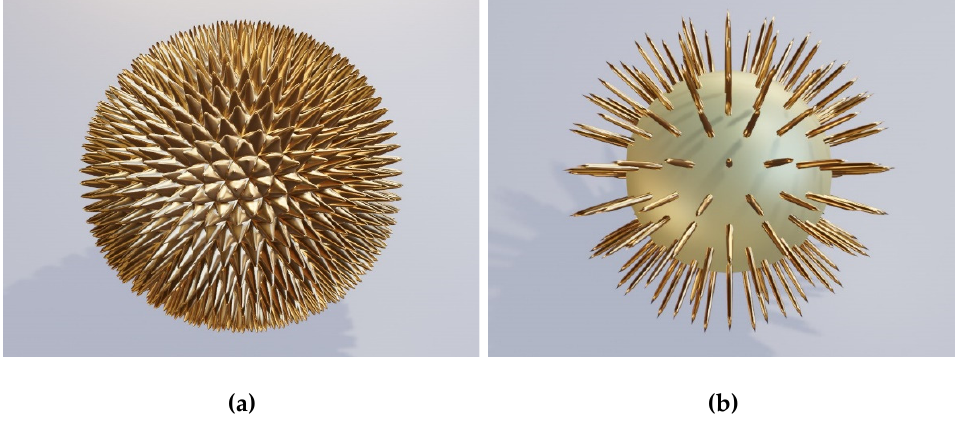
Figure 6. Brochosome-inspired plasmonic spheres with metal spikes on the surface; ( a ) rounded trigonal pyramids; ( b ) Surface metal wire-like spikes. trigonal pyramids; ( b ) Surface metal wire-like spikes.